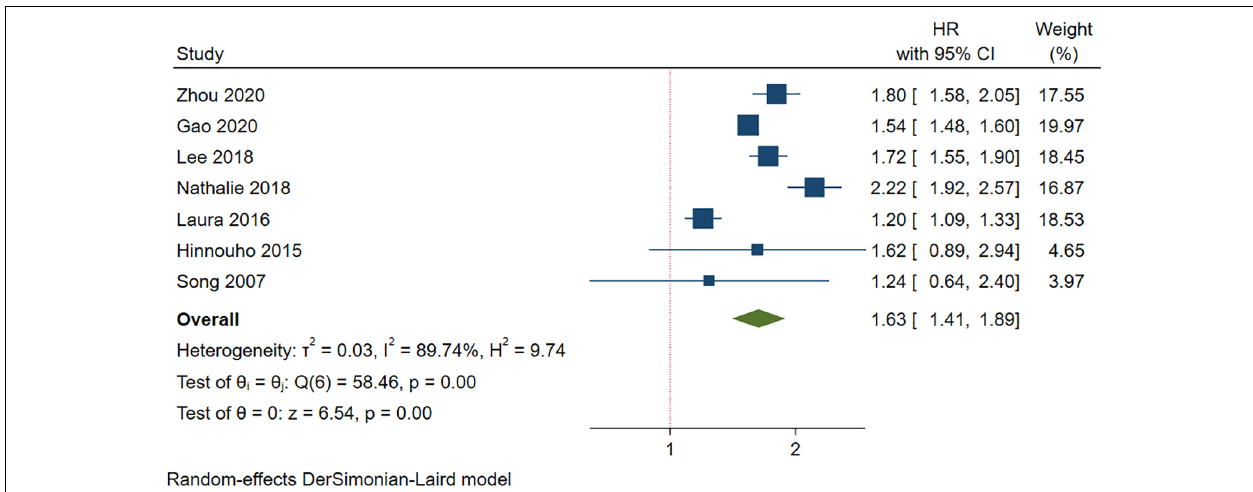
FIGURE 3 | Meta-analysis of the risk of stroke in the MUNW phenotypes compared with the MHNW phenotypes. MUNW, metabolically unhealthy normal weight; MHNW, metabolically healthy normal weight.